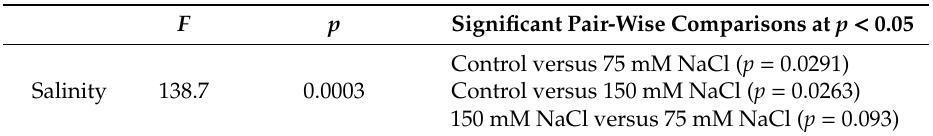
E ff ect of salinity on volatile organic compounds (VOCs) according to the one-way PERMANOVA